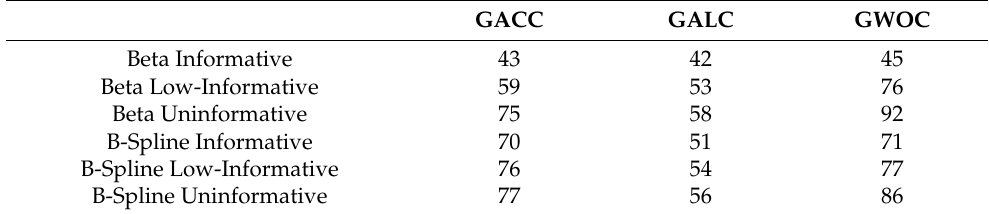
Table 1. Optimal sample sizes were defined following GACC, GALC, and GWOC estimation methods using different prior distributions, length = 0.2, coverage = 0.95. GACC GALC GWOC Beta Informative 43 42 45 Beta Low-Informative 59 53 76 Beta Uninformative 75 58 92 B-Spline Informative 70 51